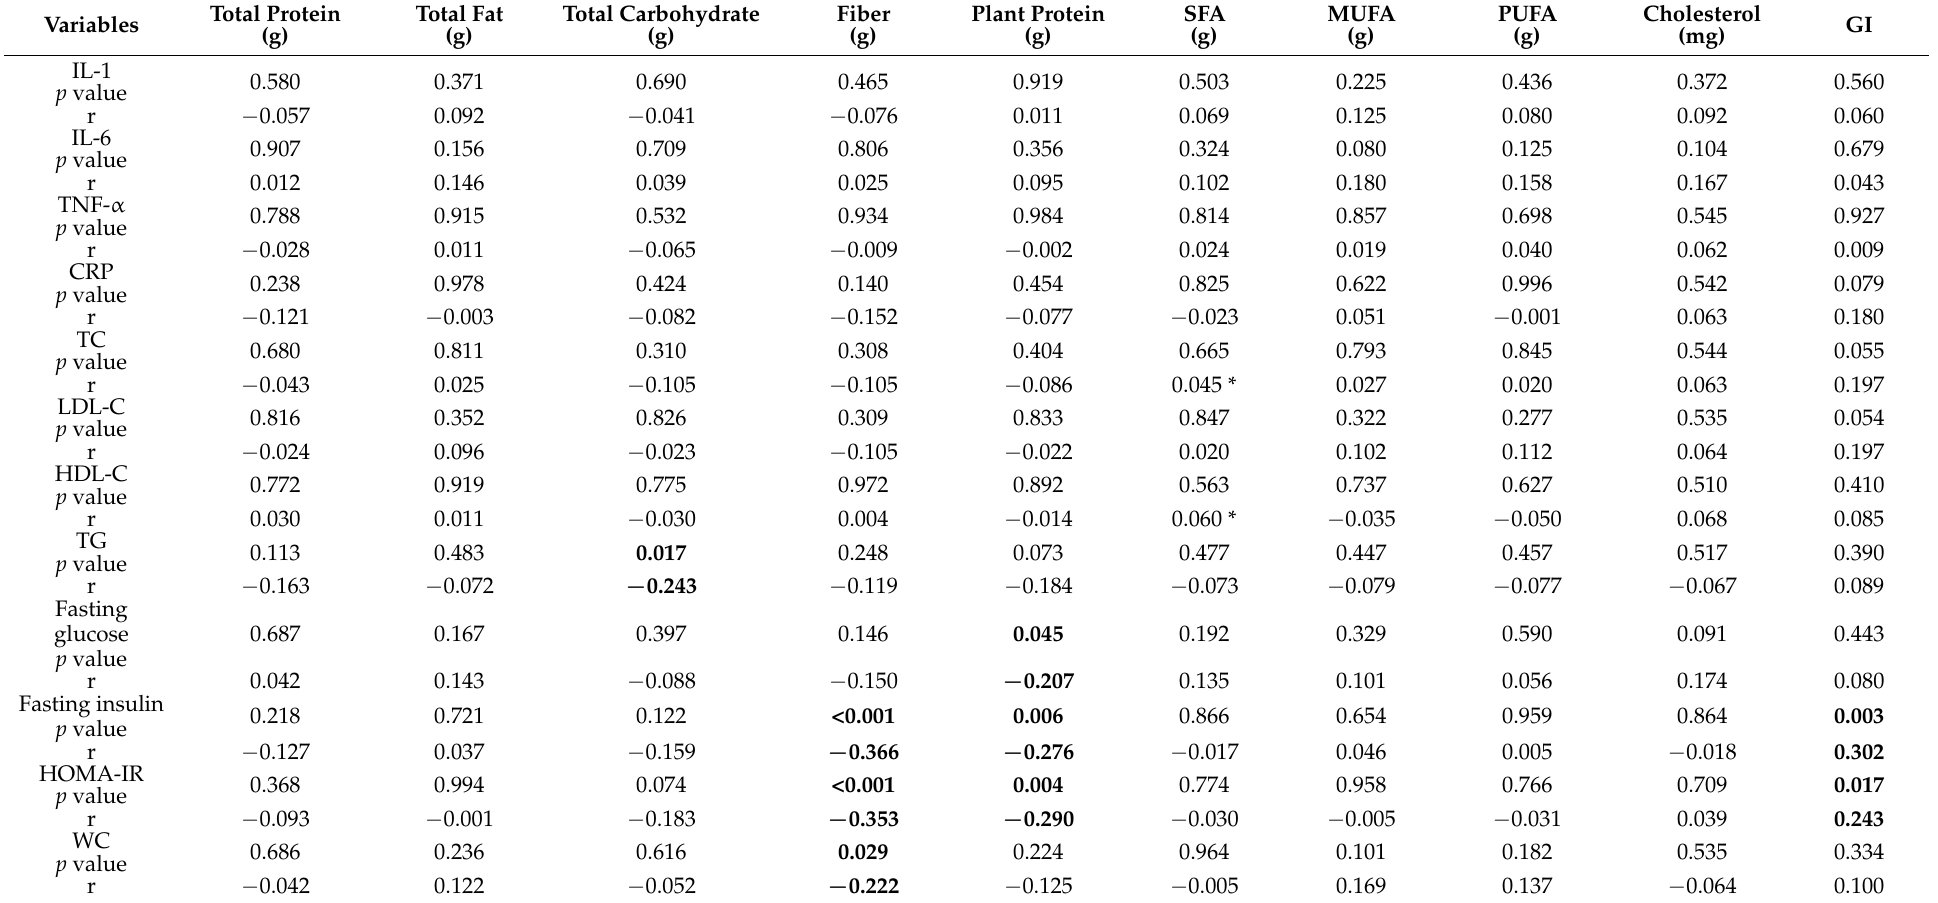
Table 3. Spearman and Pearson’s correlations among energy, macronutrients intake and inflammatory and metabolic markers in adolescent